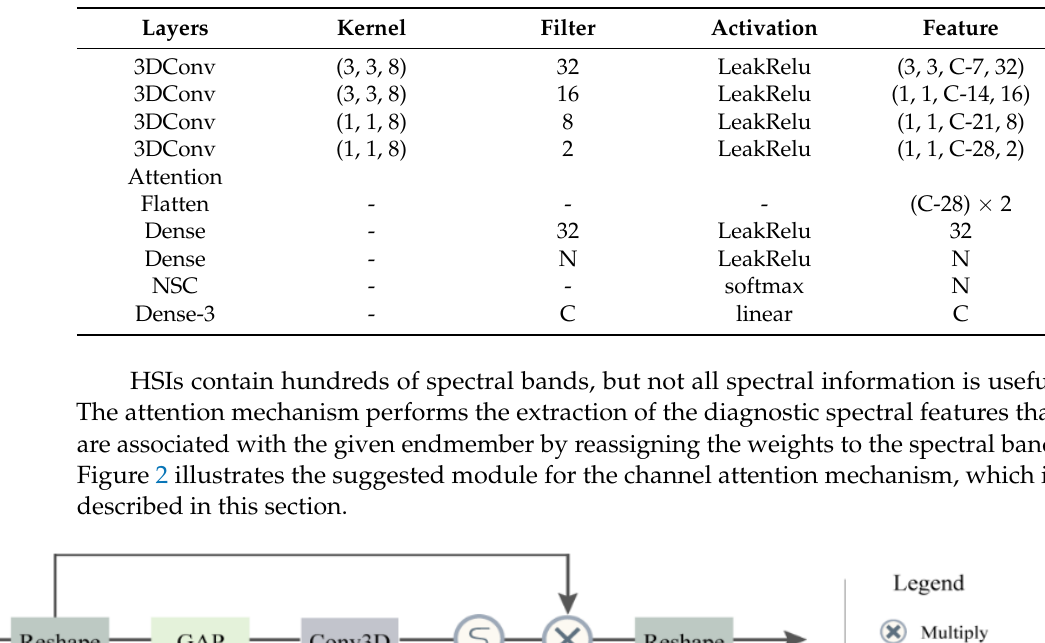
Figure 2. The architecture of the channel attention module.